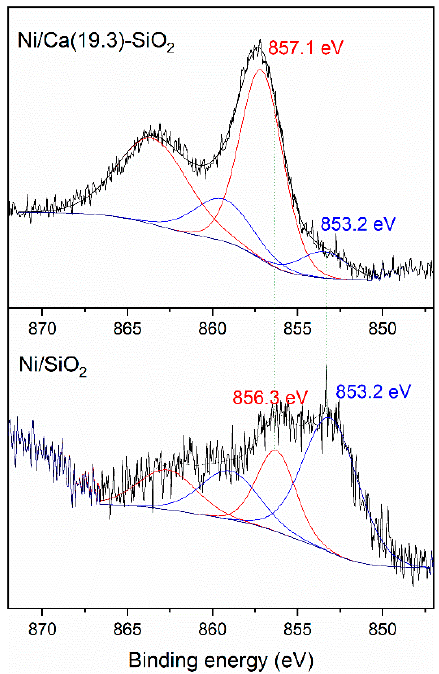
Figure 3. X-ray photoelectron spectroscopy (XPS) spectra of Ni 2p 3/2 region of reduced Ni/SiO 2 and Ni/Ca(19.3)-SiO 2 catalysts.